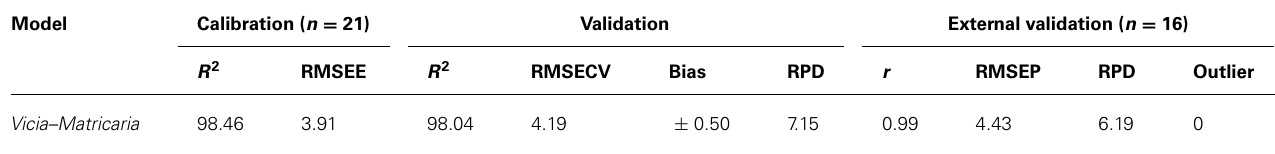
Table 1 | Statistical parameters of the two-component FT-IR–ATR model for Vicia faba and Matricaria chamomilla in terms of calibration, validation and external test set validation.